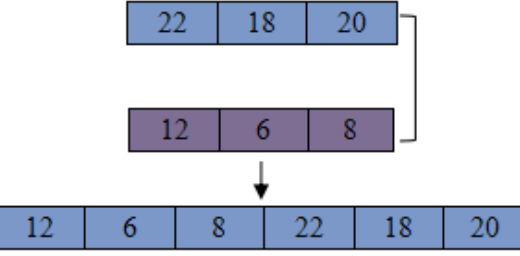
Figure 4. Spiral position updates approach.